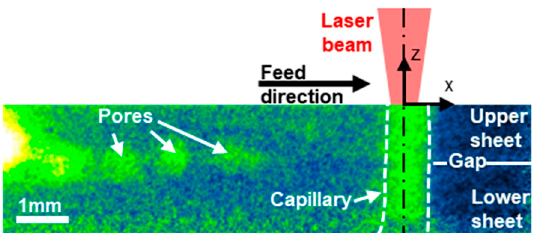
Figure 2. Single frame of an X-ray video of the pore formation process during welding in overlap configuration of uncleaned AA6016 sheets with a feed rate of 12 m/min, a beam diameter of 500 µm, and a laser power of 8.5 kW. Green-, yellow-, and white-colored areas indicate zones of low density.